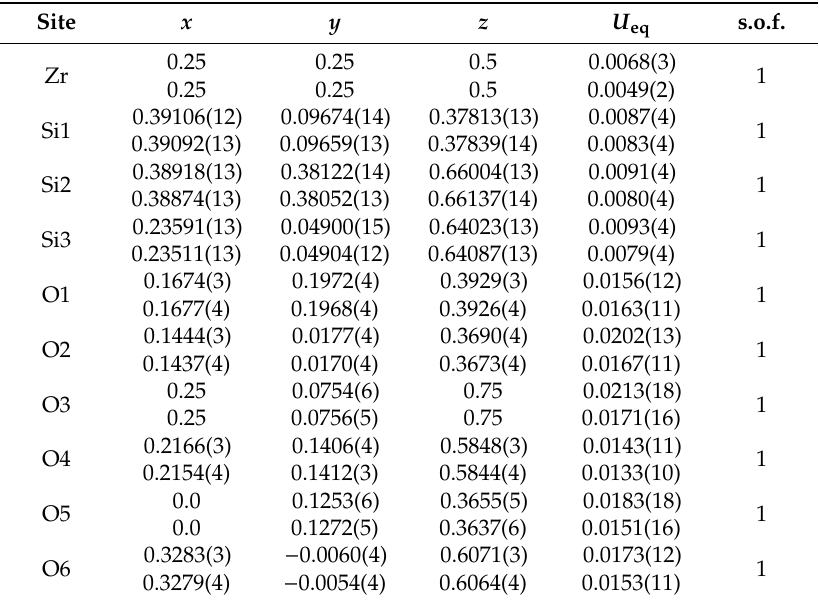
Table 6. Atom coordinates, equivalent displacement parameters (in Å 2 ) and site occupancy factors (s.o.f.) for Ag-exchanged forms of elpidite. The data for sample I and II are given in the first and the second lines of each row,